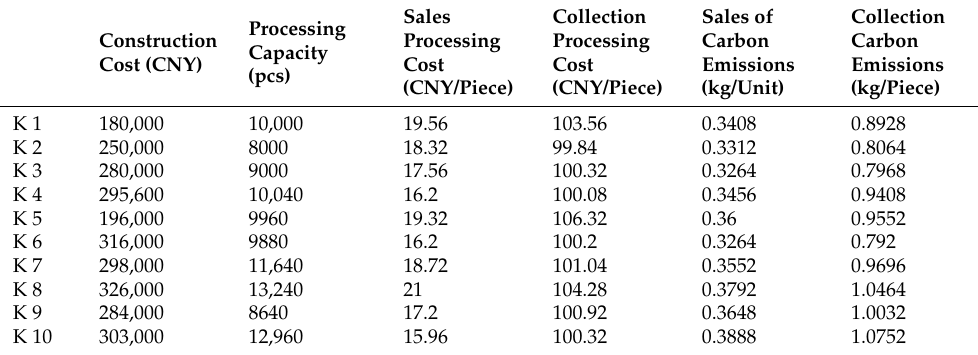
Table A12. Details of various costs, processing capacities, and unit carbon emissions of sales/collection center K.